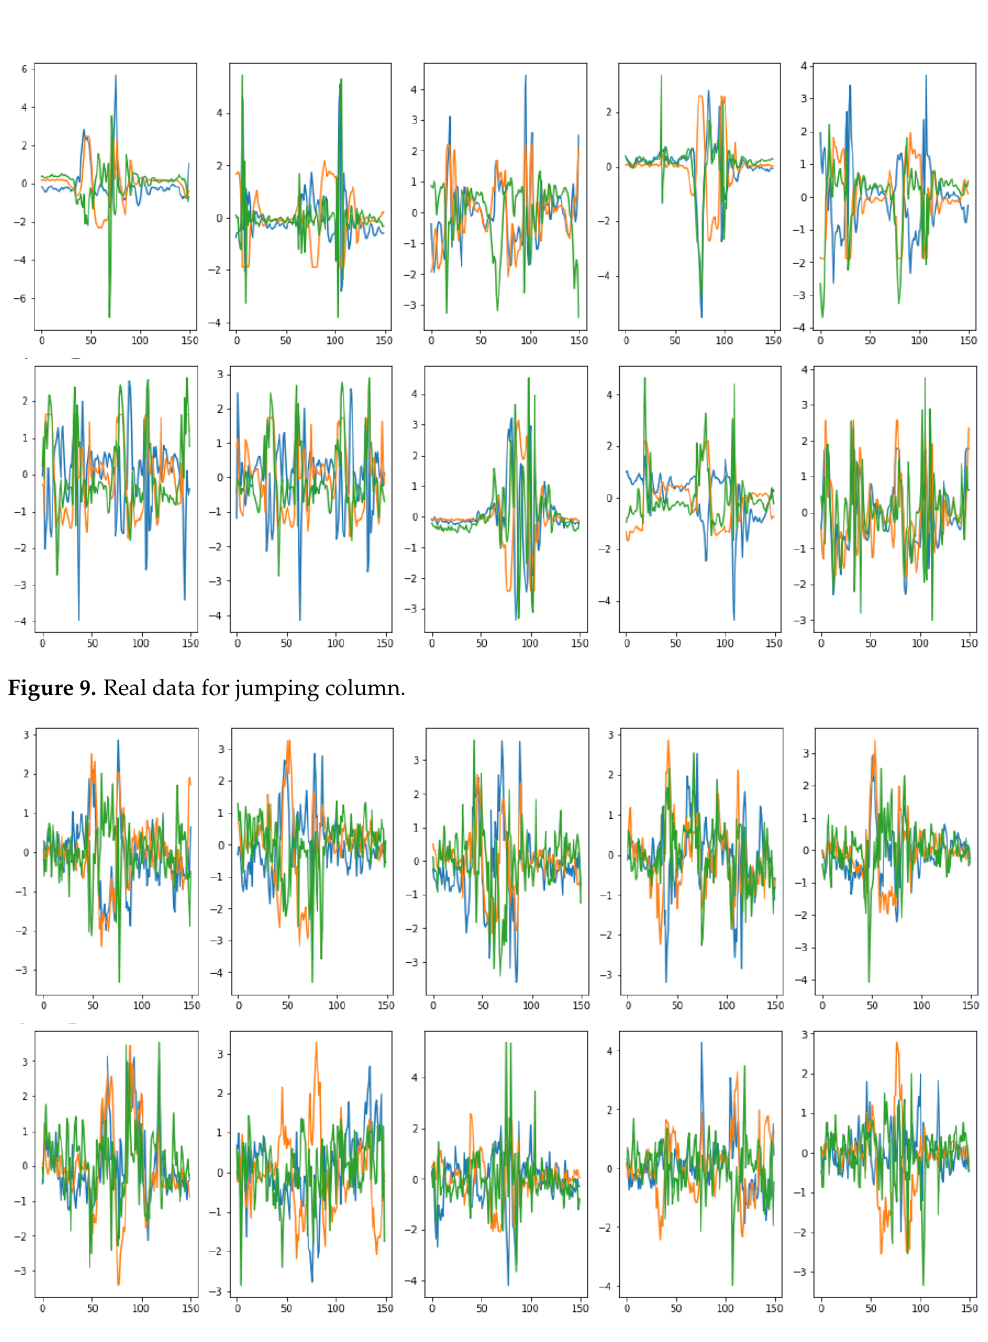
Figure 10. Generated synthetic data for jumping